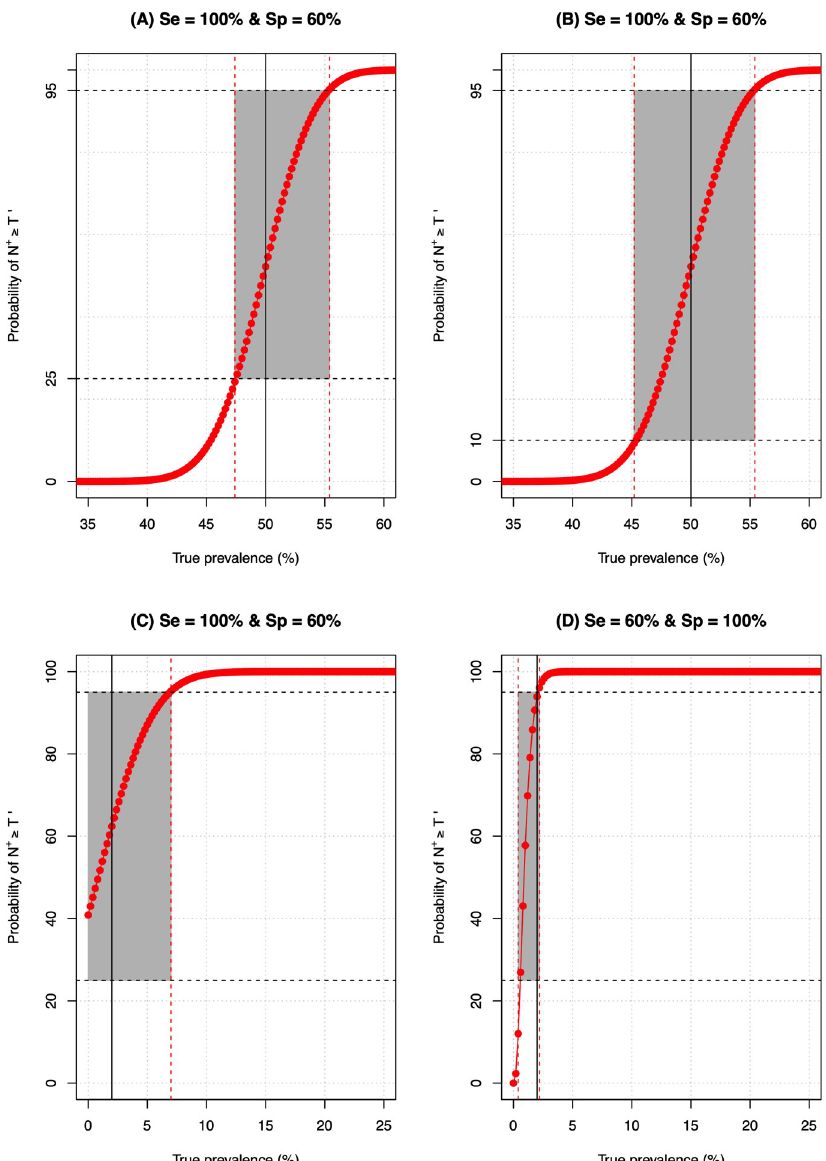
Fig 5. The impact of program decision errors and diagnostic performance on the grey zone. The red line in each panel represents the probability (in %) of the number of positive test results ( N + ) in a random sample of N subjects tot (= 500) being at least T 0 (see Eq 3 ) ( Panels A and B : T = 50%, Panels C and D : T = 2%) using 2 theoretic distinct imperfect diagnostic tests D 1 and D 2 ( Se = 100% and Sp = 60% ( Panels A , B and C ); Se = 60% and Sp = 100% d 1 d 1 d 2 d 2 ( Panel D )). The grey area represents the range of true underlying prevalence for which program decision is inadequate ( ε > 25% and ε > 5% ( Panels A, D and C ) or not ideal ( ε > 10% and ε > 5% ( Panel B overtreat undertreat overtreat undertreat